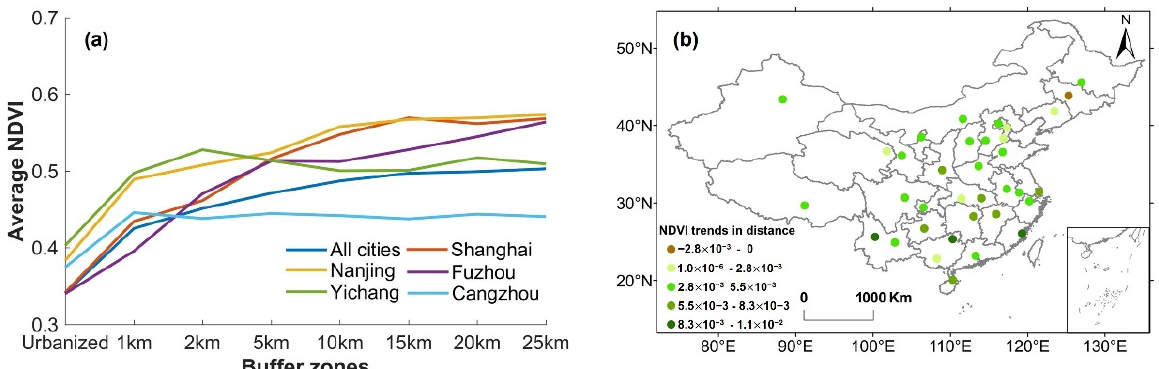
Figure 4. ( a ) Average NDVI for all 35 cities and 5 selected cities (Shanghai, Chengdu, Harbin, Yichang, and Dali) from the urban area to its seven buffer zones; ( b ) NDVI trends in distance from urban area to 25 km buffer zones for all cities. Here, NDVI trends in distance indicates NDVI slope from urban area to 25 km buffer zone. Values larger than 0 indicate that NDVI increases from urban area to 25 km buffer zone, and values lower than 0 indicate the opposite trend.